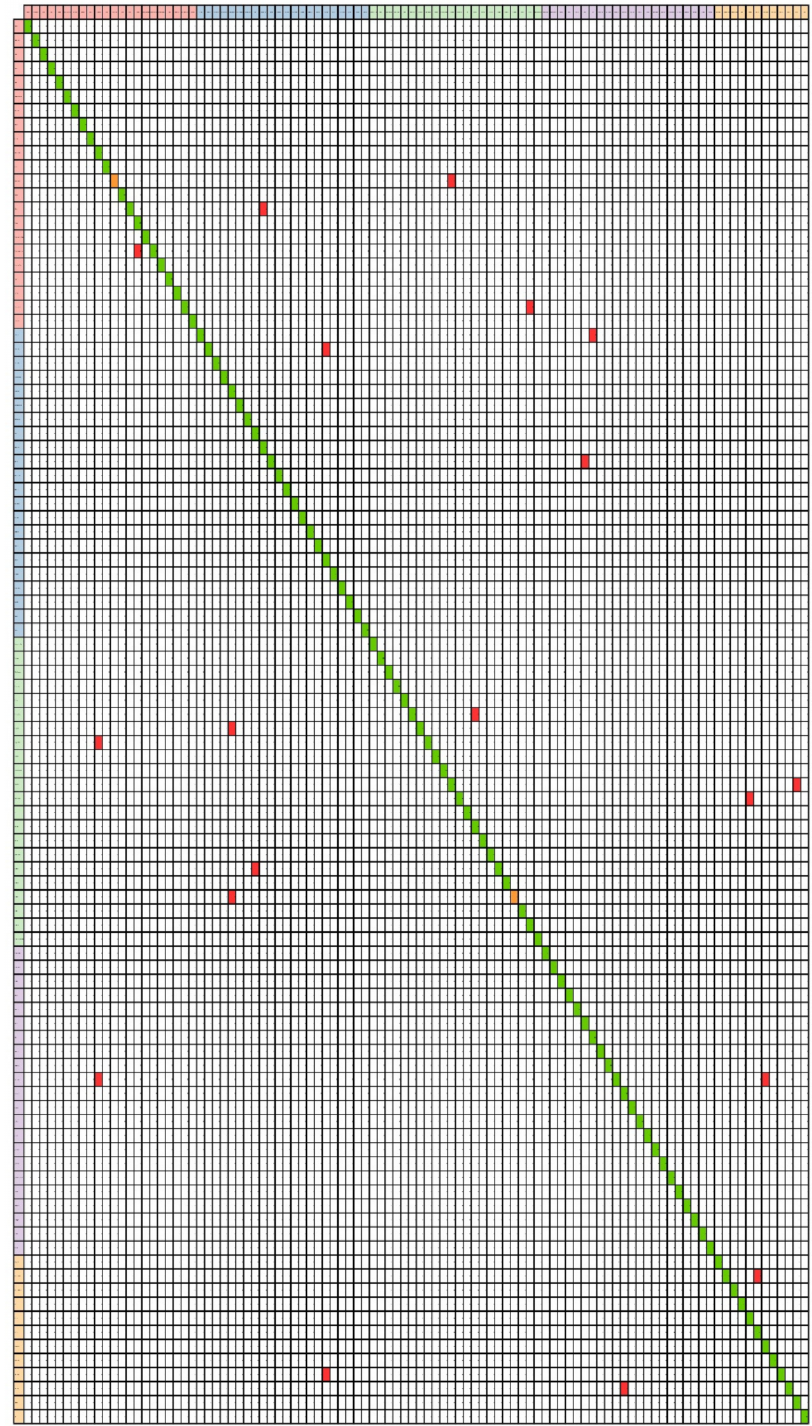
Figure A2. Confusion matrix of 100